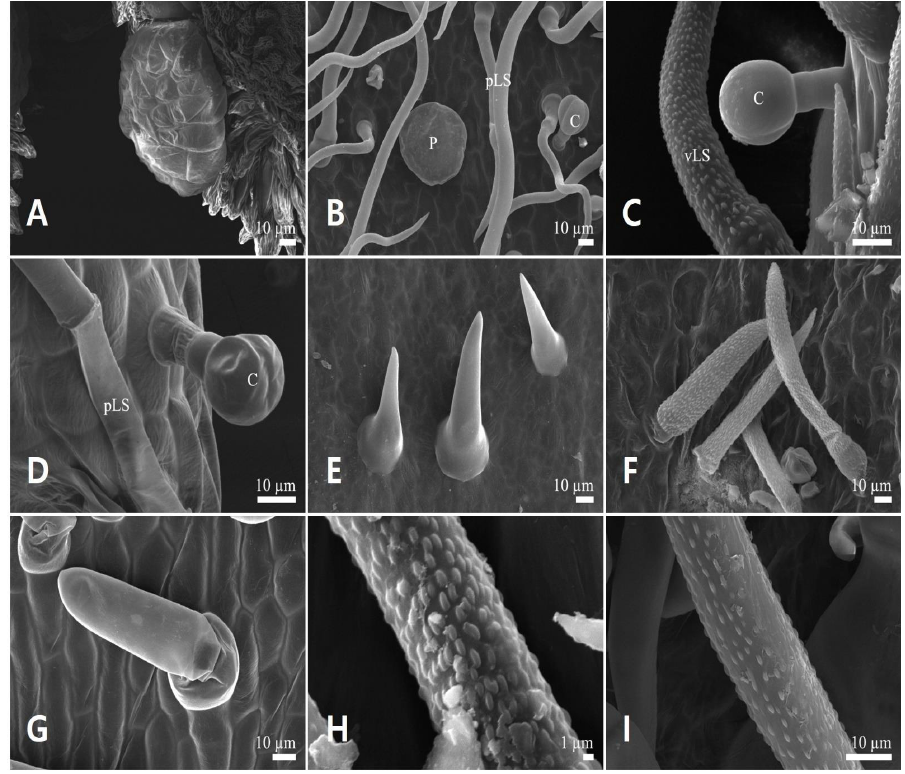
Figure 10. Floral trichome diversity in the two Leonurus species. ( A , B , F , I ) Leonurus macranthus . ( C – E , G – H ) Leonurus japonicus . ( A ) Scale-like multicellular glandular trichome. ( B ) Four-celled capitate stalked glandular trichome, peltate glandular trichome, and smooth-surfaced long simple trichomes. ( C ) Capitate stalked glandular trichome and verrucate-surfaced long simple trichome. ( D ) Capitate stalked glandular trichome and smooth-surfaced long simple trichome. ( E,G ) Smooth-surfaced short simple trichomes. ( F ) Verrucate-surfaced short simple trichomes. ( H , I ) Verrucate-surfaced trichomes. C , capitate stalked glandular trichome; pLS , smooth-surfaced long simple trichome; P , peltate glandular trichome; vLS , verrucate-surfaced long simple trichome. Peltate glandular trichomes ( P , Figure 10B) had one cell, a 40 –80 μm diameter head, and a smooth surface. They were distributed on the abaxial side of the calyx, and on the upper and lower lips in L. japonicus and L. macranthus . However, on the adaxial side of the calyx lobe, this type of trichome was observed in L. japonicus (Table 3). Scale-like glandular trichomes ( S , Figure 10A) had a multi-cellular (up to 24 cells) gland of 68.7 ± 6.35 μm and 100.9 ± 7.17 μm diameter in L. japonicus and L. macranthus , respectively. Moreover, a fragile straight line was observed on the horizontal diametrical region of the head (Figure 4A). These trichomes were distributed on the abaxial sides of anthers in L. japonicus and L. macranthus (Table 3).